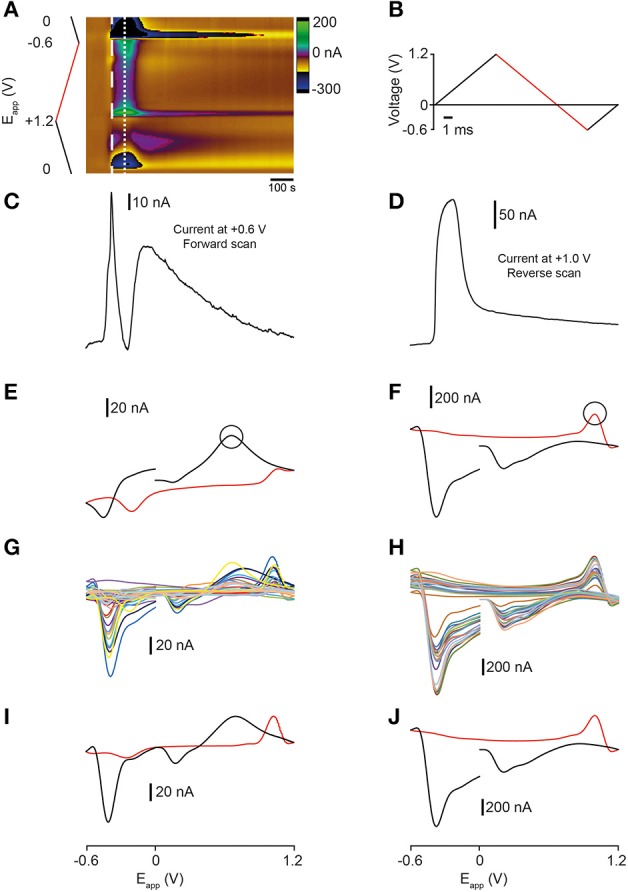
Comparison of analytes evoked by high K+ aCSF stimulation of the zebrafish telencephalon. (A) Color plot showing changes in current following stimulation with high K+ aCSF. (B) Applied waveform ranging from 0 V → +1.2 V → −0.6 V → 0 V (the holding potential). The forward scan of the waveform is colored black and the reverse scan is red. (C) Current vs. time plot showing the profile of current changes at Eapp = ~ +0.6 V, the point in the waveform indicated by the black circle in (E). (D) Current vs. time plot showing the profile of current changes at Eapp = ~ +1.0 V on the reverse scan of the waveform, the point indicated by the circle in (F). (E) Representative cyclic voltammogram taken at the time point indicated by the thick dashed white line in (A). (F) Representative cyclic voltammogram taken at the time point indicated by the thin dashed white line in (A). (G) Cyclic voltammograms from 24 separate stimulations taken at the time point indicated by the thick dashed white line in (A). (H) Cyclic voltammograms from 20 independent experiments taken at the time point indicated by the thin dashed white line in (A). (I) Average cyclic voltammogram derived from data presented in (G). (J) Average cyclic voltammogram derived from data presented in (H).